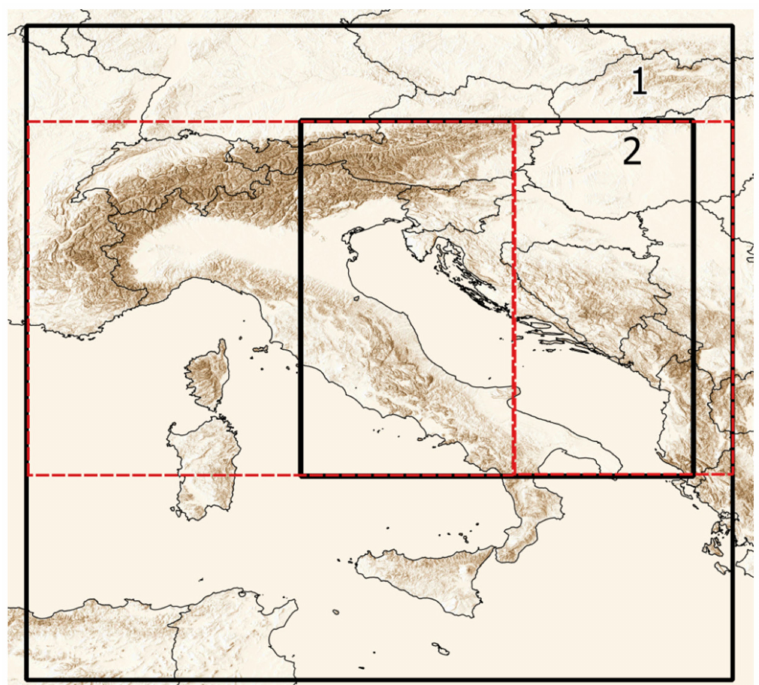
Figure 1. Region of interest with topography in brown. Outer domain ( 1 ) and the nested inner domain ( 2 ) used in the WT algorithm for WT computation in solid black. The horizontal red dashed lines indicate 40 ◦ N and 48 ◦ N, while the vertical line indicates 16 ◦ E. The red lines divide the outer domain into four regions and are used to associate numbers 1–4 to the corresponding WT, as shown in Table